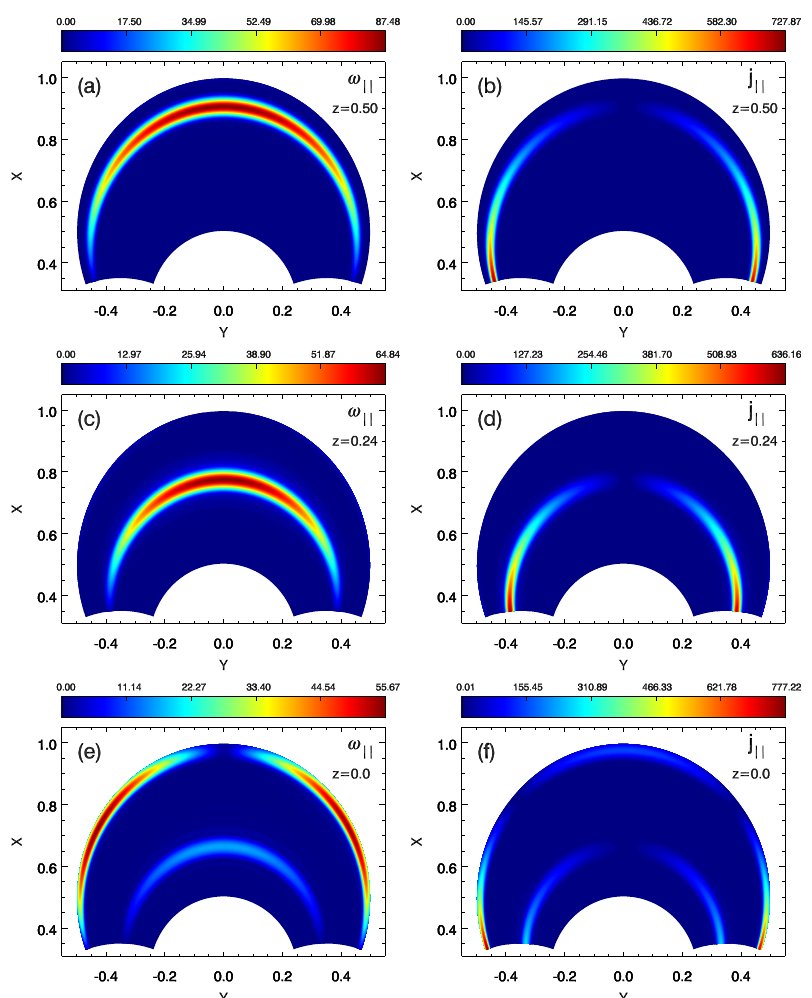
Figure 2. Magnitude of the normal mode’s field aligned vorticity, | ω (cid:107) | ( a , c , e ), and current, | j | ( b , d , f ) at z = 0.5 ( a , b ), 0.24 ( c , d ), and 0.0 ( e , f (cid:107)